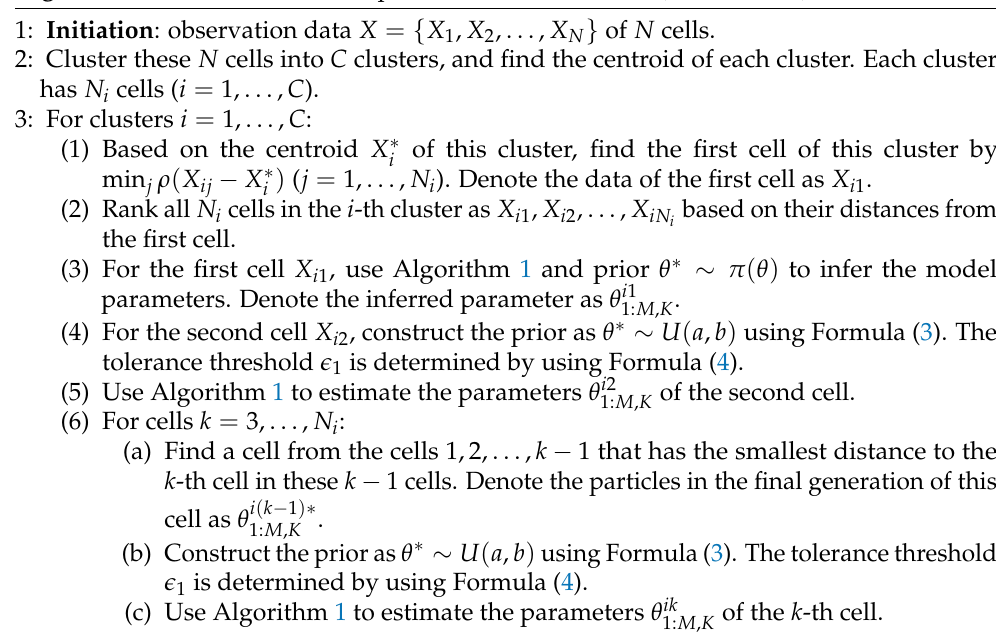
Algorithm 2 ABC-PMC with adaptive tolerance threshold